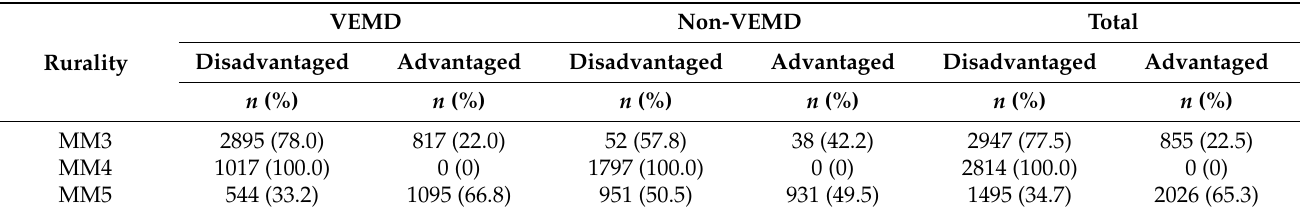
Table 5. Comparing Non-VEMD and VEMD reporting hospital presentations for children from areas of Disadvantage and Advantage in the context of Rurality.